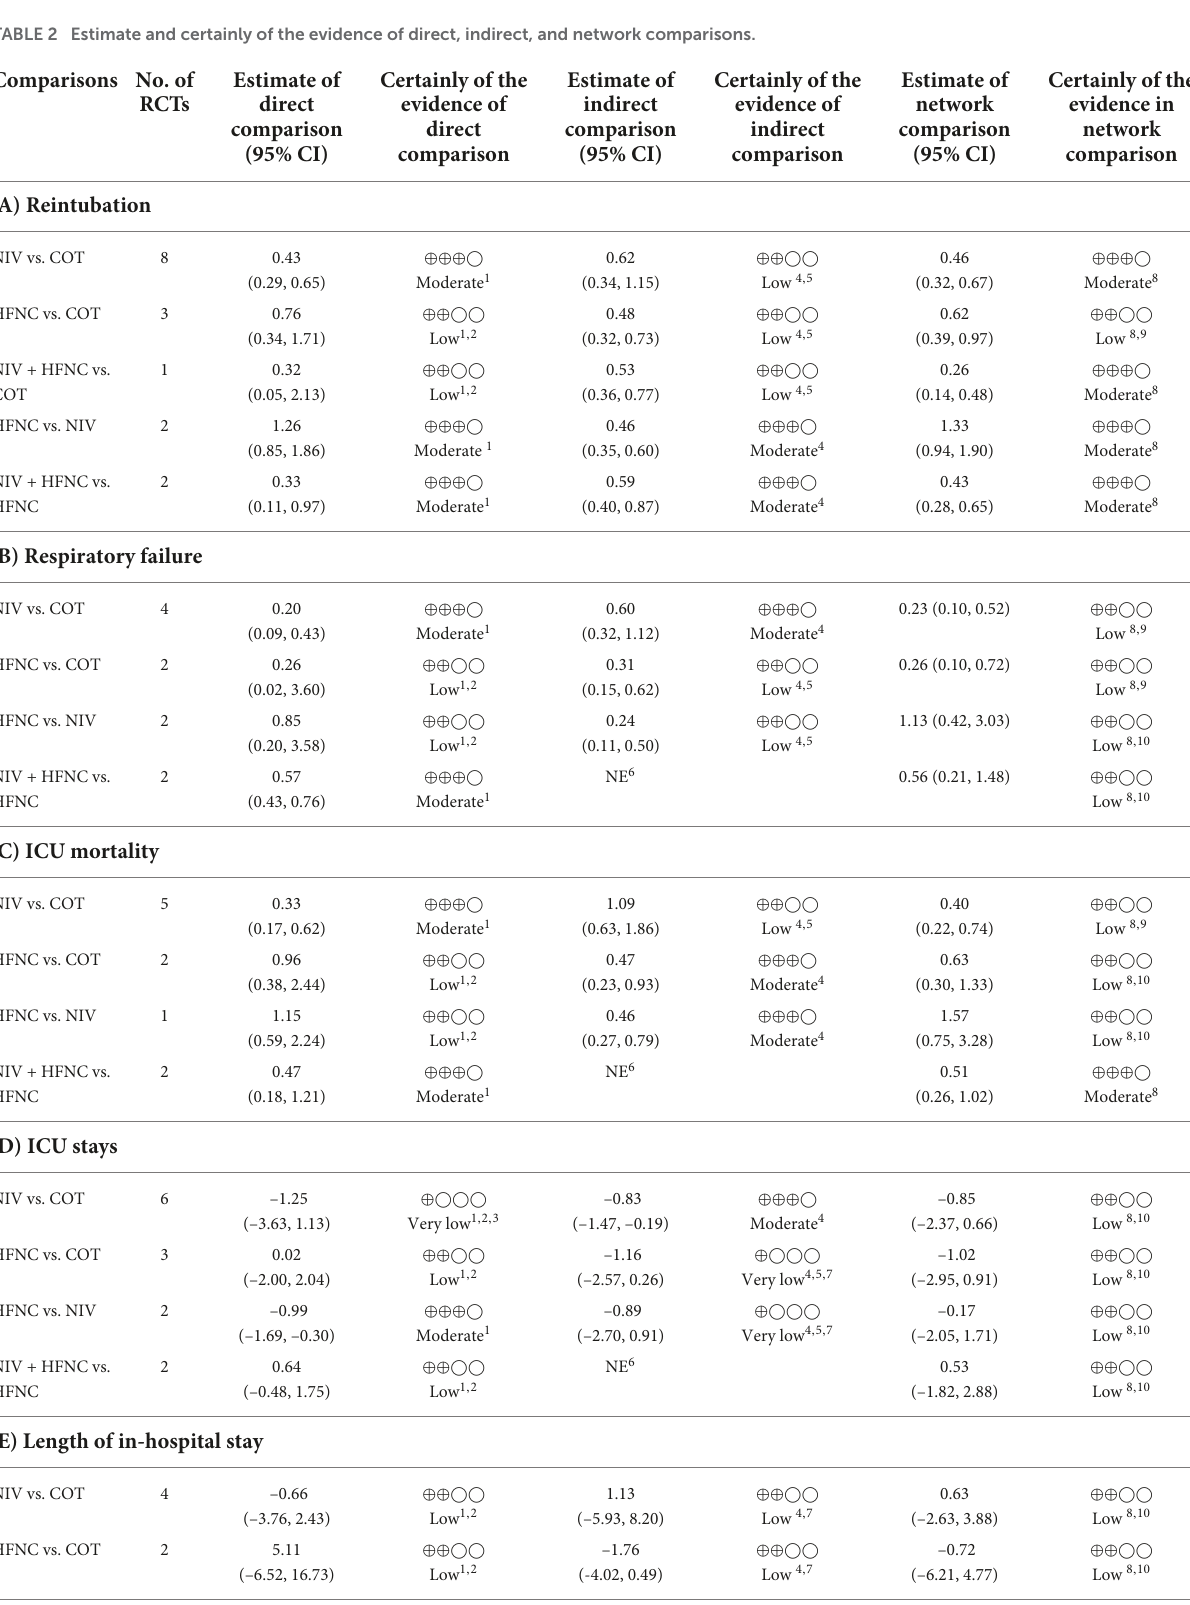
TABLE 2 Estimate and certainly of the evidence of direct, indirect, and network comparisons. Comparisons No. of